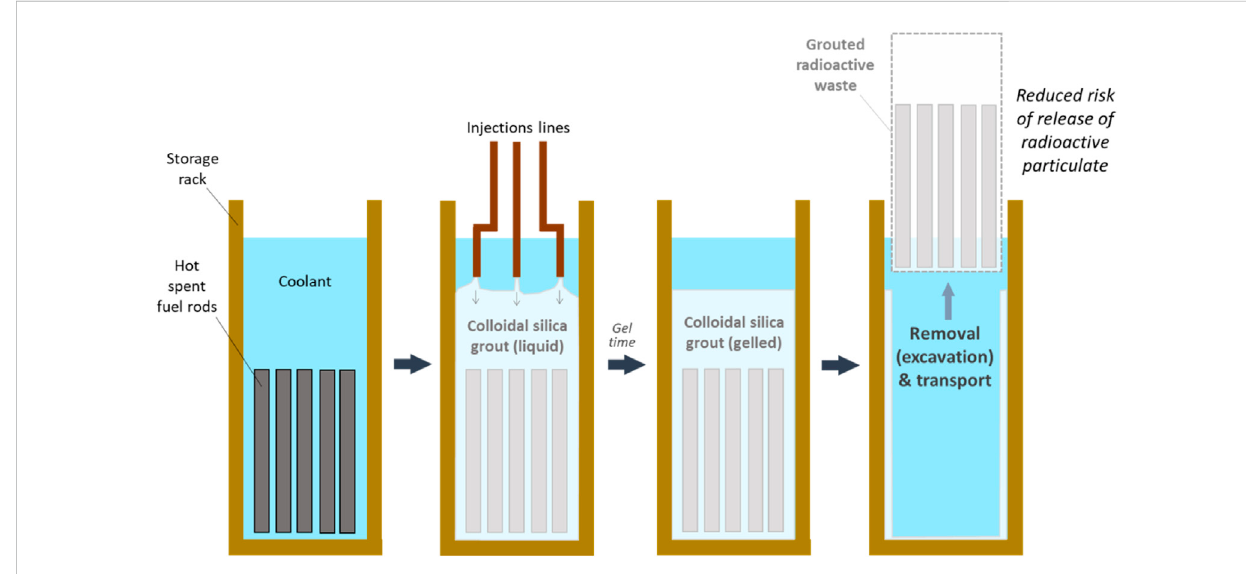
FIGURE 1 Example of pre-treatment of radioactive waste (in standard storage conditions) with colloidal silica grout, prior to removal and transport.